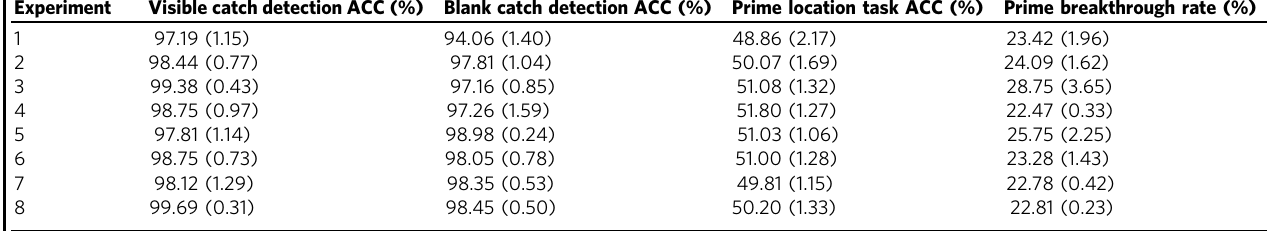
Table 1 Objective measures on behavioral